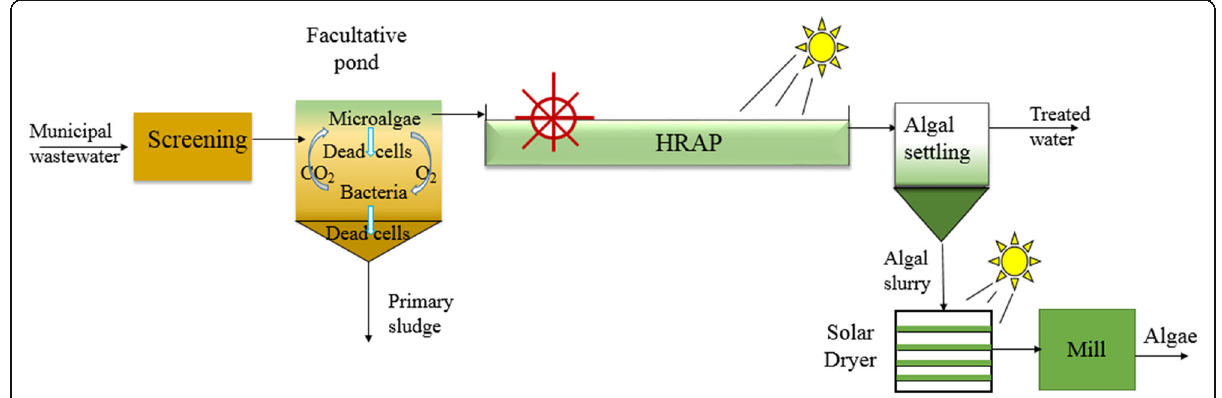
Fig 1 Schematic diagram of the HRAP system at Zenin